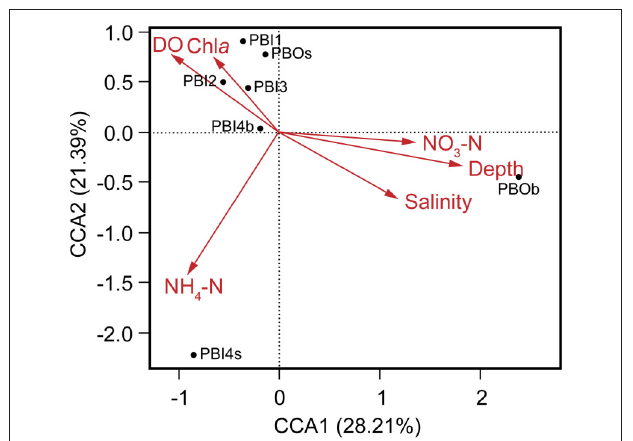
FIGURE 6 | Canonical correspondence analysis of the relationship between the relative viral abundance of viral species and environmental factors. DO, dissolved oxygen; Chl a , chlorophyll a ; NO 3 -N, nitrate; NH 4 -N,